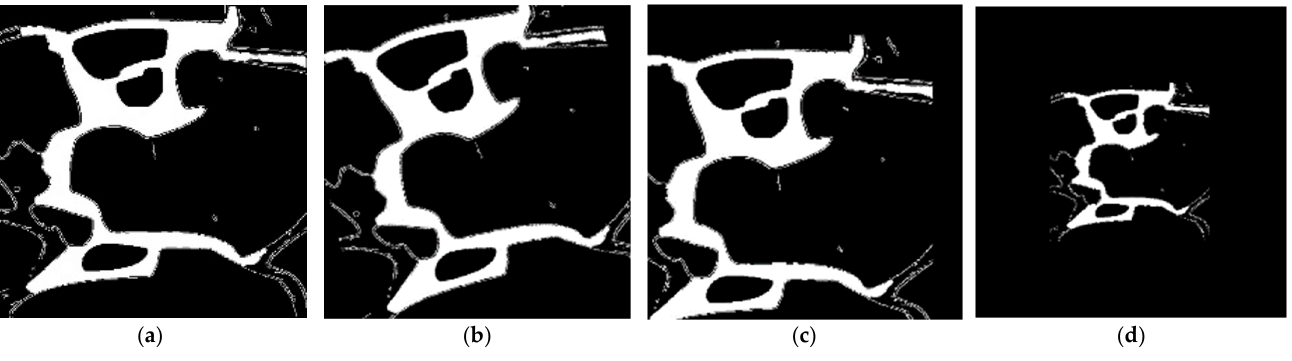
Figure 9. Data augmentation effect diagram, ( a ) Original image, ( b ) Rotation ( c ), Translation, ( d ) Zoom.